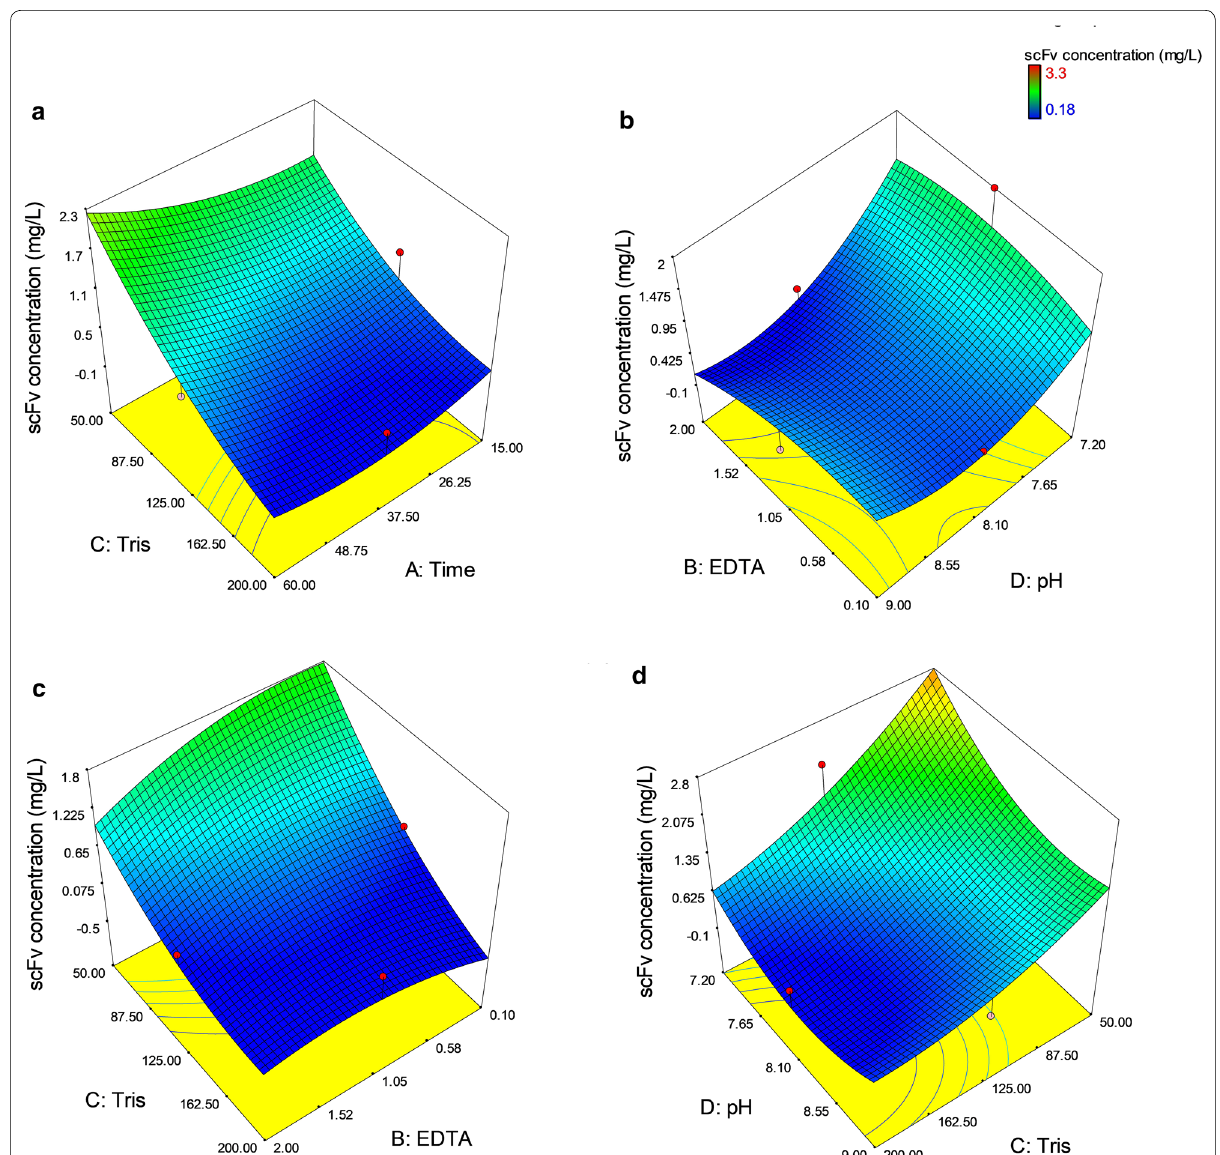
Fig. 4 Response surface plots associated with the extraction yield of periplasmic anti-G17-Gly scFv. The statistically significant interaction terms effective in the anti-G17-Gly scFv extraction (mg/L) are showed by the response surface plots: a The interaction between incubation time and Tris–HCl concentration (AC); b The interaction between EDTA and pH (BD); c The interaction between EDTA and Tris–HCl concentration (BC); d The interaction between Tris–HCl concentration and pH